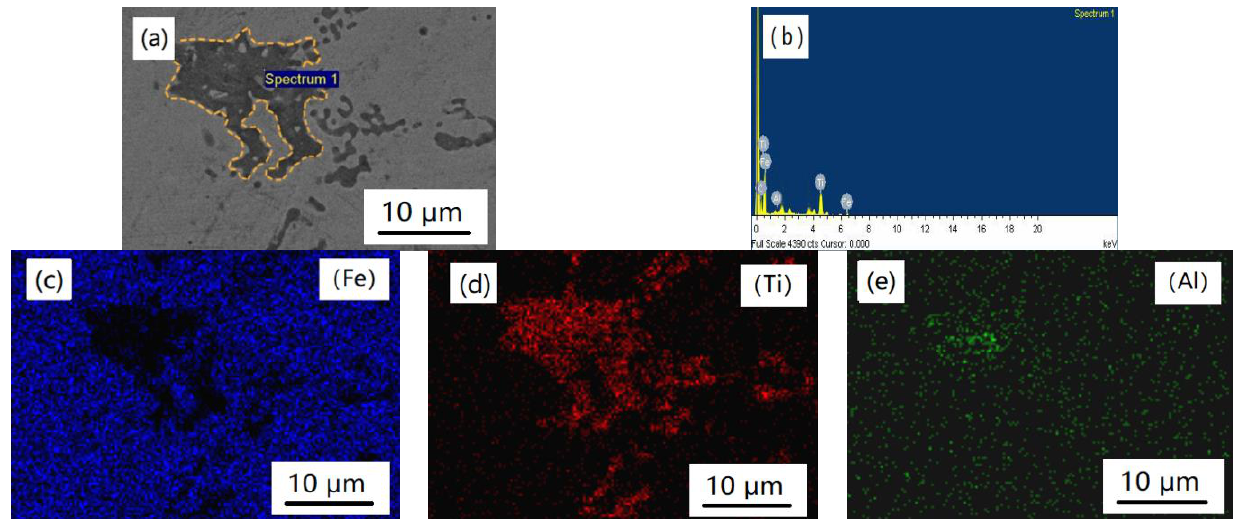
Figure 4. Morphology and EDS analysis results of TiC x in the (Ti 3 AlC 2 + SiC)/Fe composites: ( a ) micrograph, ( b ) EDS results of spectrum 1, ( c ) Fe, ( d ) Ti, and ( e )